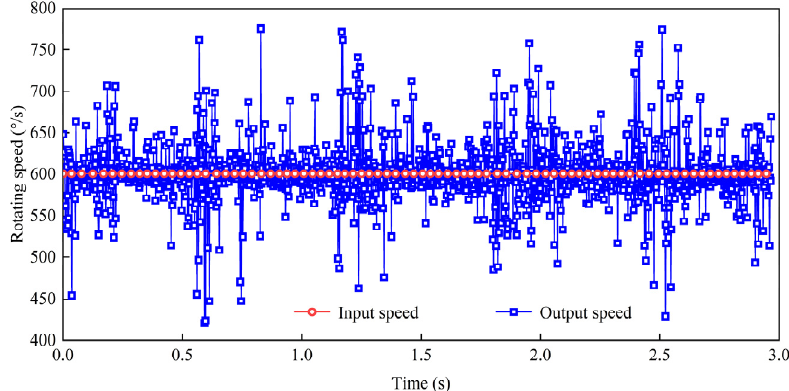
Figure 12. Input and output speeds of flexible joint.